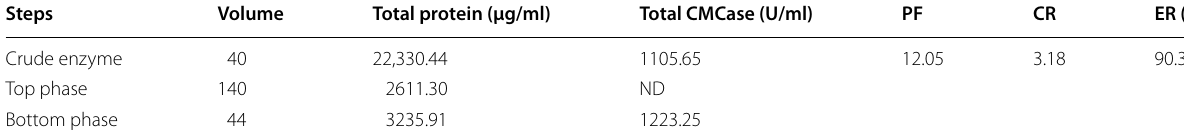
Table 1 Purification of recombinant enzyme Egls using PEG 4000-phosphate-NaCl system